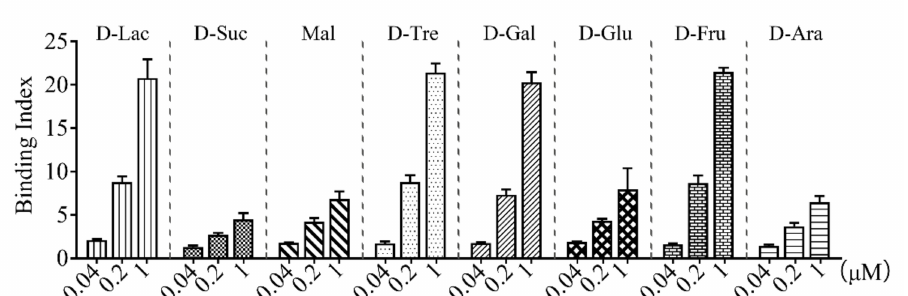
Figure 4. Carbohydrate binding ability of rCsGal-8. Binding of different concentrations of rCsGal-8 to various carbohydrates, including D-lactose (D-Lac), D-sucrose (D-Suc), maltose (Mal), D-trehalose (D-Tre), D-galactose (D-Gal), D-glucose (D-Glu), D-fructose (D-Fru) and D-arabinose (D-Ara), was detected by ELISA with PBS as a control. Values are the means of three experimental replicates and shown as means ±